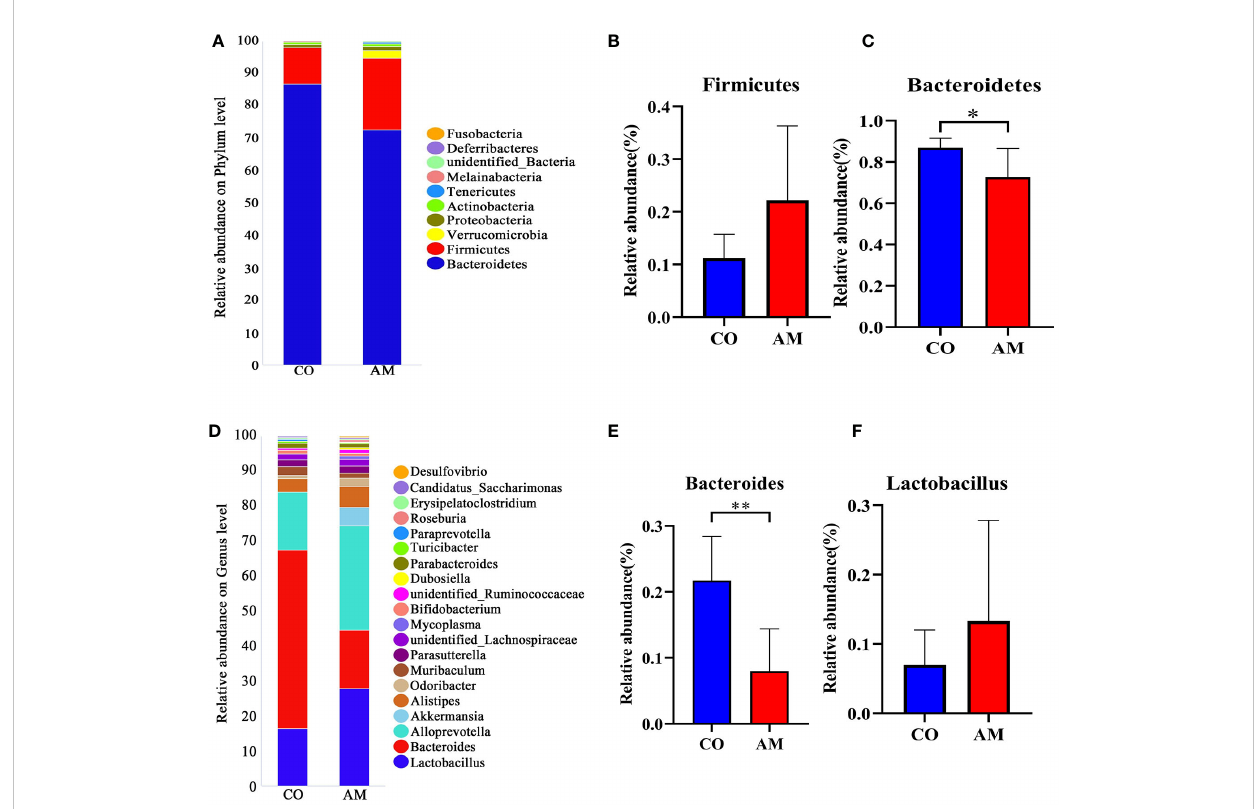
FIGURE 3 Composition of gut microbiota in control and AM groups. (A) Composition of species at phylum level. (B) The relative abundance of Firmicutes (n=8 per group). (C) The relative abundance of Bacteroidetes (n=8 per group). (D) Composition of species at genus level. (E) The relative abundance of Bacteroides (n=8 per group). (F) The relative abundance of Lactobacillus (n=8 per group). *, P <0.05, **, P